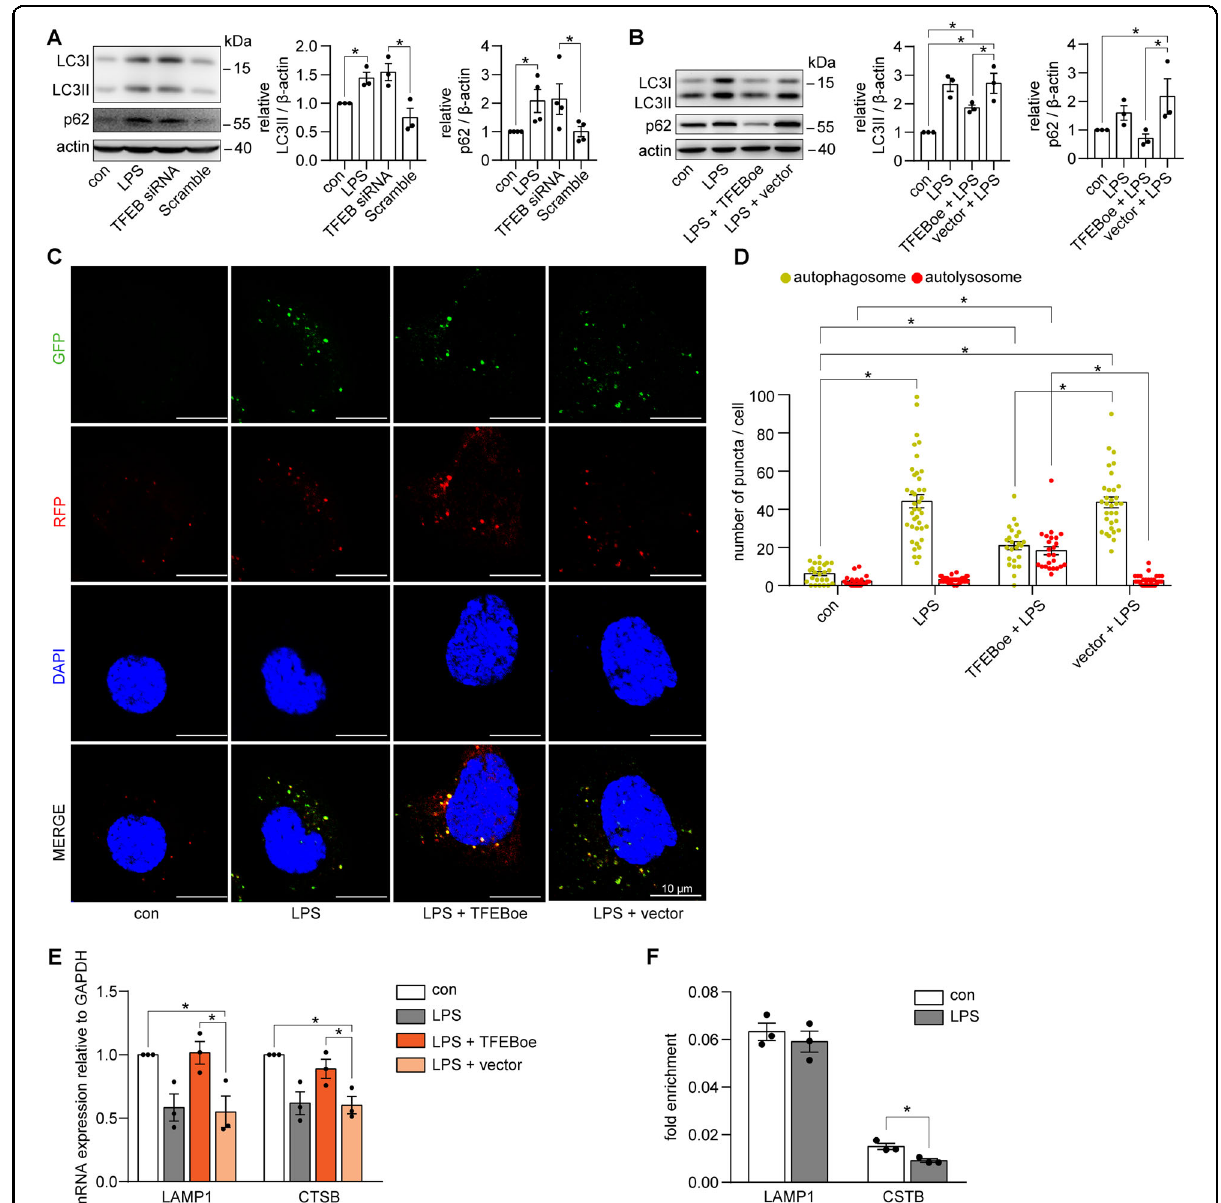
Fig. 7 TFEB regulated the autophagic degradation in LPS-treated cultured PTECs. A Immunoblot of LC3 and p62 in cultured PTECs treated with LPS, TFEB siRNA, or Scramble siRNA (scramble) for 24 h. Similar to LPS treatment, TFEB siRNA led to an accumulation of LC3II and p62 ( n = 3 – 4). B Immunoblotting of LC3 and p62 in cultured PTECs treated with LPS, LPS plus TFEB-overexpression adenovirus (TFEBoe), or LPS plus vector adenovirus (vector) for 24 h. Overexpression of TFEB decreased the accumulation of LC3II and p62 in LPS-treated PTECs ( n = 3). C , D Cultured PTECs transfected with mRFP-GFP-LC3 adenovirus and treated as indicated for 24 h. Representative confocal laser scanning microscopy images ( C ) and quantitative analysis ( D ) of autophagosomes (yellow puncta) and autolysosomes (red-only puncta). Overexpression of TFEB induced the formation of autolysosomes, whereas it decreased the accumulation of autophagosomes in LPS-induced PTECs ( n = 3 – 4, 25 – 39 cells from each group). Scale bar = 10 μ m. * P < 0.05. E RT-qPCR analyses of the expression of LAMP1 and CTSB in cultured PTECs treated as indicated for 12 h. Overexpression of TFEB rescued the decreased mRNA levels of LAMP1 and CTSB in LPS-treated PTECs ( n = 3). F ChIP analyses of the binding of TFEB to the promoters of LAMP1 and CTSB in cultured PTECs treated as indicated for 24 h, using an antibody to TFEB. IgG was used as a negative control. Quantitative PCR was conducted to measure the immunoprecipitated DNA using a promoter-speci fi c primer. TFEB binding to the promoter of CTSB but not LAMP1 was inhibited in the LPS-treated cultured PTECs ( n = 3). Data were expressed as faction of input. * P < 0.05.